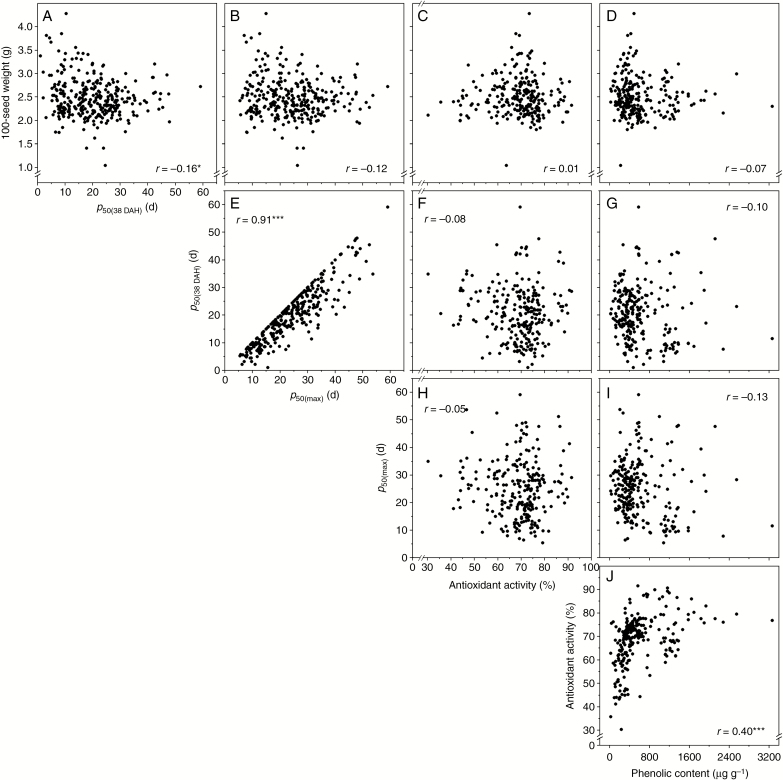
Correlations between 100-seed weight, p50(38DAH), p50(max), caryopsis antioxidant activity and caryopsis phenolic content for 299 Indica rice accessions. Correlation coefficients (r) were significant at *P < 0.05 or ***P < 0.001 (two-sided tests).